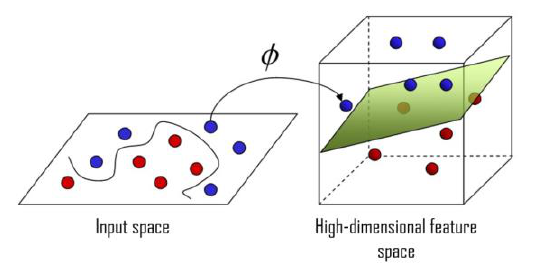
Figure 5 . The transfer the nonlinearly distributed data from two-dimensional space to three-dimensional space (Muhammed et al. 2020).